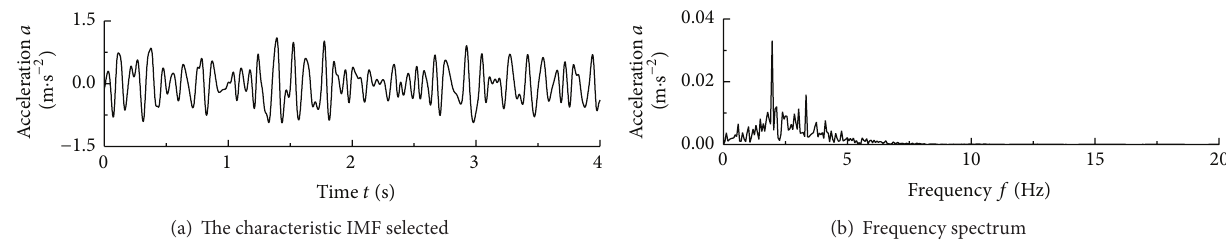
Figure 21: Analysis results of the signal presented in Figure 20 by improved EMD: (a) the characteristic IMF and (b) FFT spectrum.